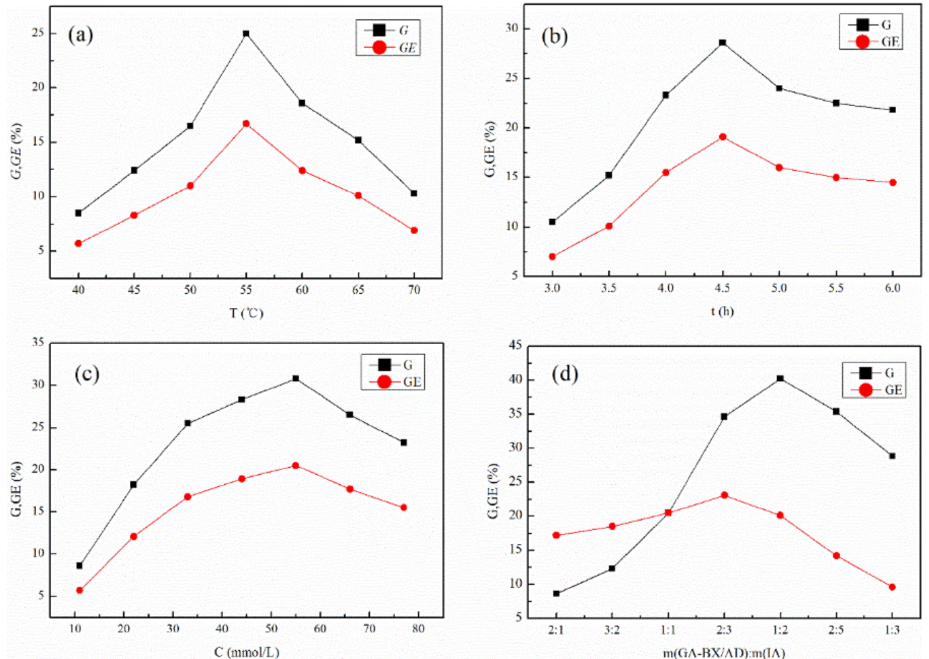
Figure 3. ( a ) Effect of reaction temperature on G and GE . ( b ) Effect of reaction time on G and GE . ( c ) Effect of initiator concentration on G and GE . ( d ) Effect of monomer quality on G and GE